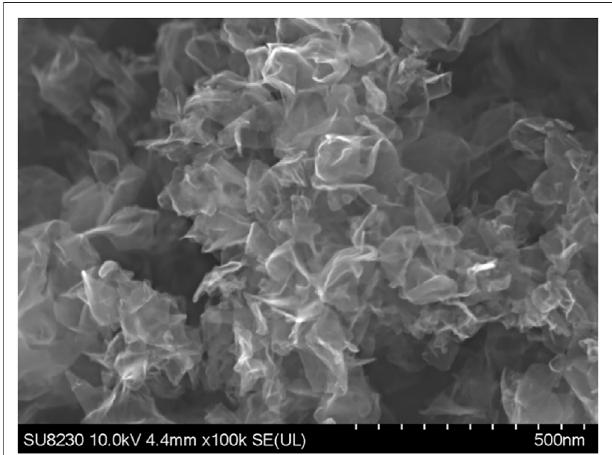
FIGURE 4 | SEM image of the KWI polymers graphene fl akes.